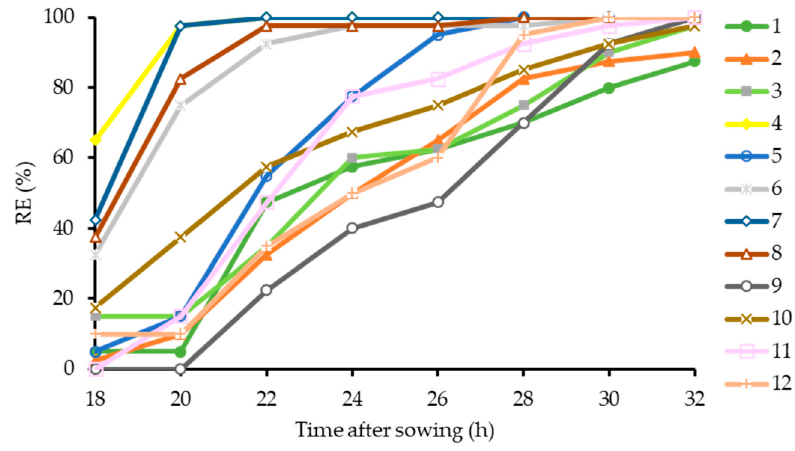
Figure 3. Germination progress curves to radicle emergence (RE > 2 mm) between 18 and 32 h at 25 °C of 12 hybrid cucumber seed lots.